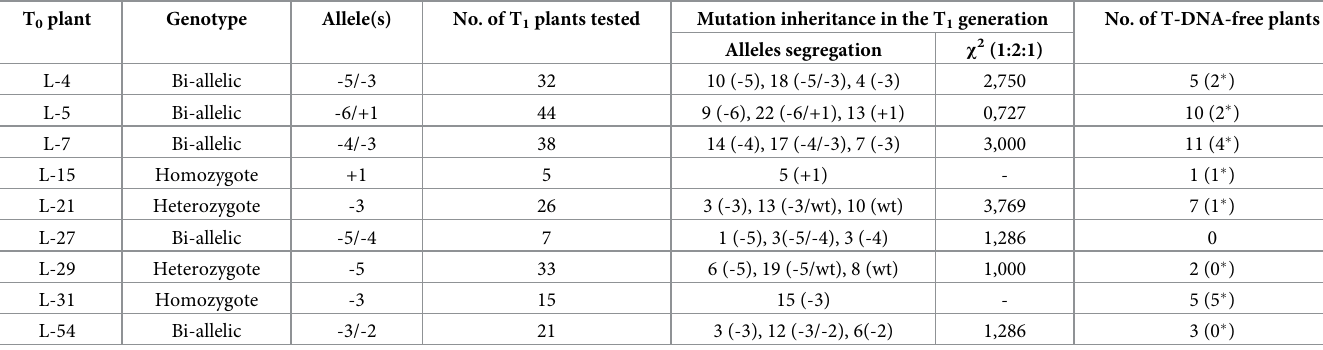
moter, PCR analysis was carried out using primers specific to Cas9 , sgRNA and HPT sequences (Table 2). A T1 individual was considered devoid of the transgene if the control amplification of the OsSWEET14 promoter was successful and if none of the PCR reactions with independent primer pairs designed on the T-DNA produced a detectable diagnostic band. The results of this PCR screen show that the T-DNA could be segregated out in the prog- eny of most T lines, with 88.9% of the T lines generating T-DNA-free progeny. In total, 44 of 0 0 221 analyzed edited T plants did not generate a specific amplicon from the T-DNA construct 1 and 15 of them were homozygous mutant harboring the desired OsSWEET14 modifications. Our results demonstrate that transgene-free, homozygous mutant individuals could be individuals. obtained in the segregating progeny of selfed T 0 Table 2. Transmission of CRISPR/Cas9 editing events to the T 1 generation.